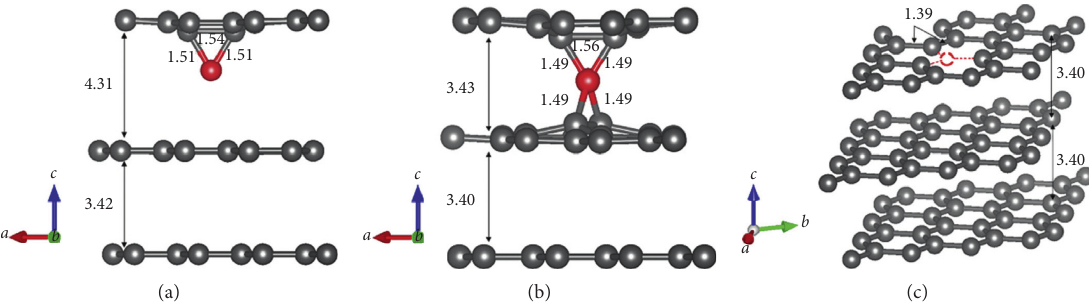
Figure 3: Geometries of vacancy and interstitial obtained by full optimization. (a) “Bridge” and (b) “spiro” interstitial structures in matrix graphite; (c) single vacancy on matrix graphite surface. Red balls represent the interstitial carbon atoms. All distances and bond lengths are in Table 1: Adsorption energies ( E ads ) for perfect and defective matrix graphite (unit: eV). Structures